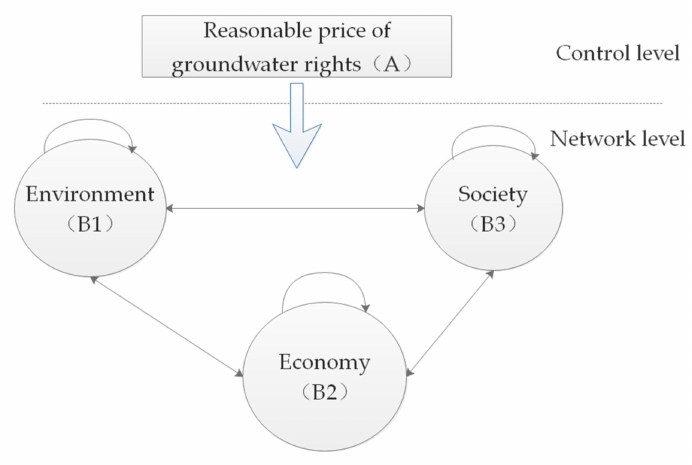
Figure 2. The network structure of clusters in the ANP model for groundwater rights pricing.